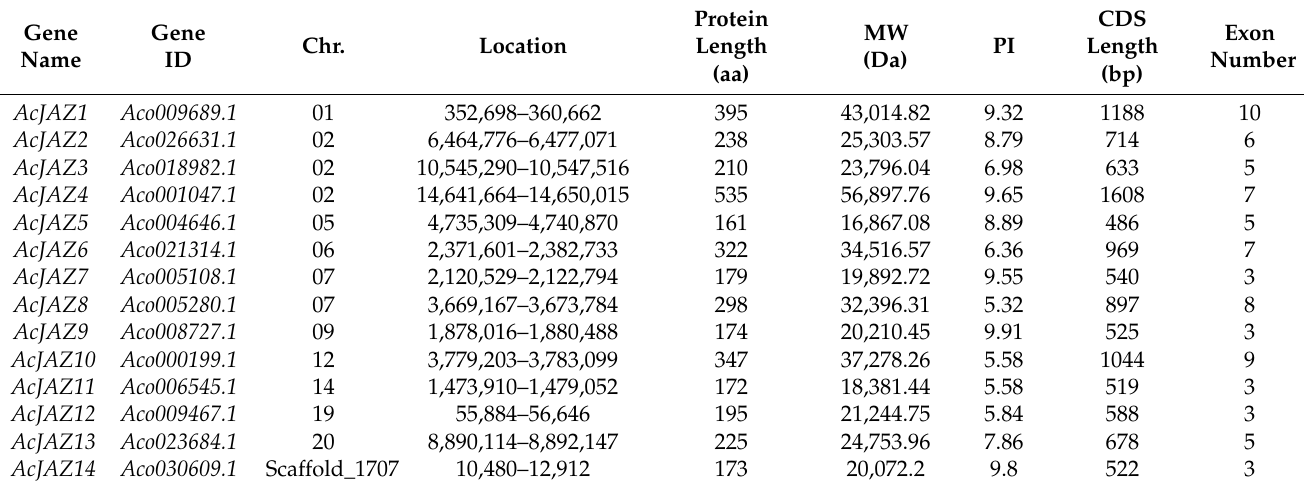
Table 1. Information of Pineapple JAZs, including gene ID, chromosome, locations, isoelectric point (pI), molecular weight (MW) protein length, CDS length, and exon